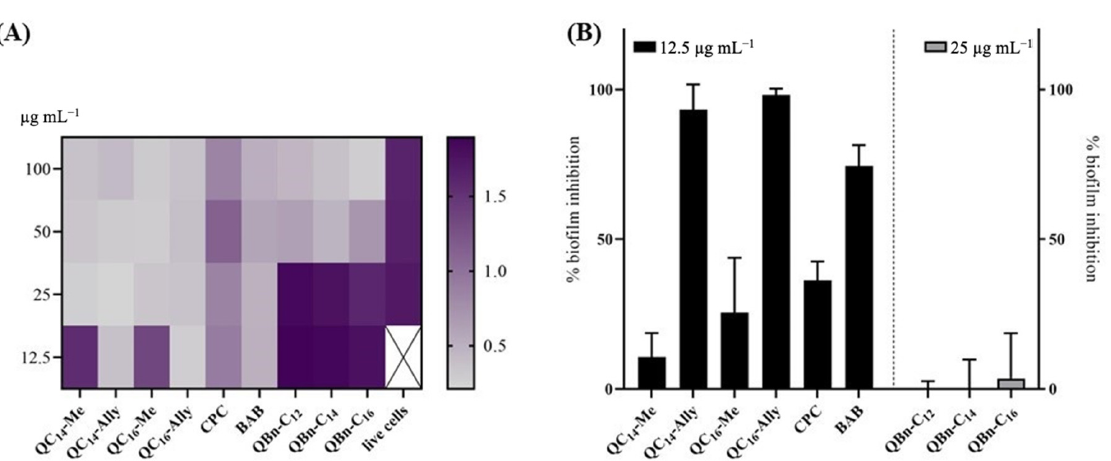
Figure 3. Inhibition of the Staphylococcus aureus ATCC 25923 biofilm upon treatment with candidate 3-amidoquinuclidine QACs, cetylpiridinium chloride (CPC), and benzyldodecyldimethylammonium bromide (BAB). The crystal violet heat map ( A ) shows the color intensity for all compounds at concentrations of 12.5, 25, 50, and 100 µ g mL − 1 . The percentage of biofilm inhibition ( B ) for all compounds at concentrations of 12.5 and 25 µ g mL − 1 . The values obtained were compared with the untreated control and are shown as the mean of at least three independent experiments performed in triplicate.